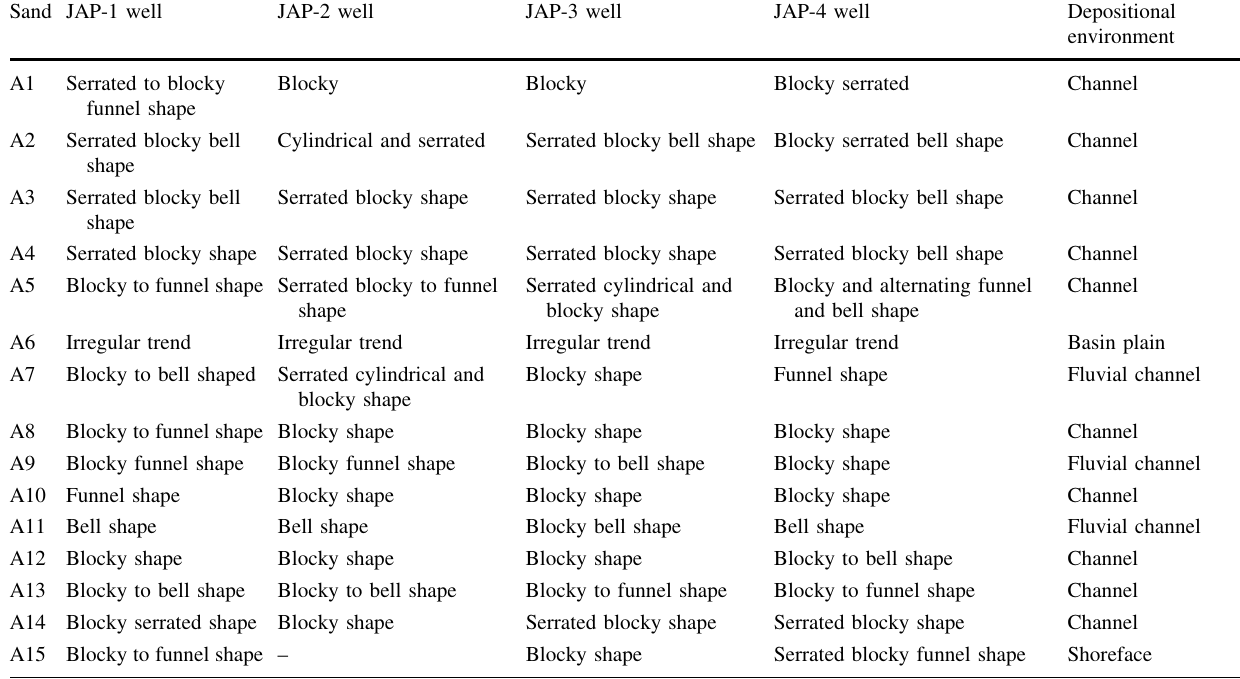
Table 1 Environments of deposition of the reservoirs in all the wells using log motifs Sand JAP-1 well